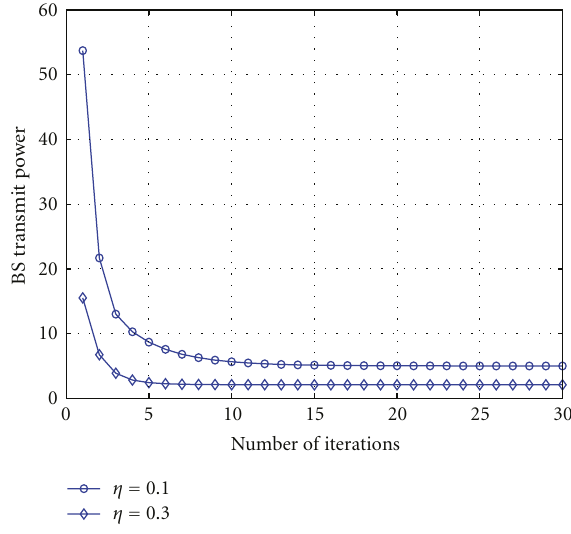
Figure 8: Convergence behavior of the proposed robust THP transceiver design in Section 4.2. CSIT uncertainty size δ 1 = δ 2 = δ = 0 . 1. N M = 2, N N L = L = 2, and t = 4, r 1 = r 2 = 2, 1 2 η = η = η = 0 . 1,0 . 1 2